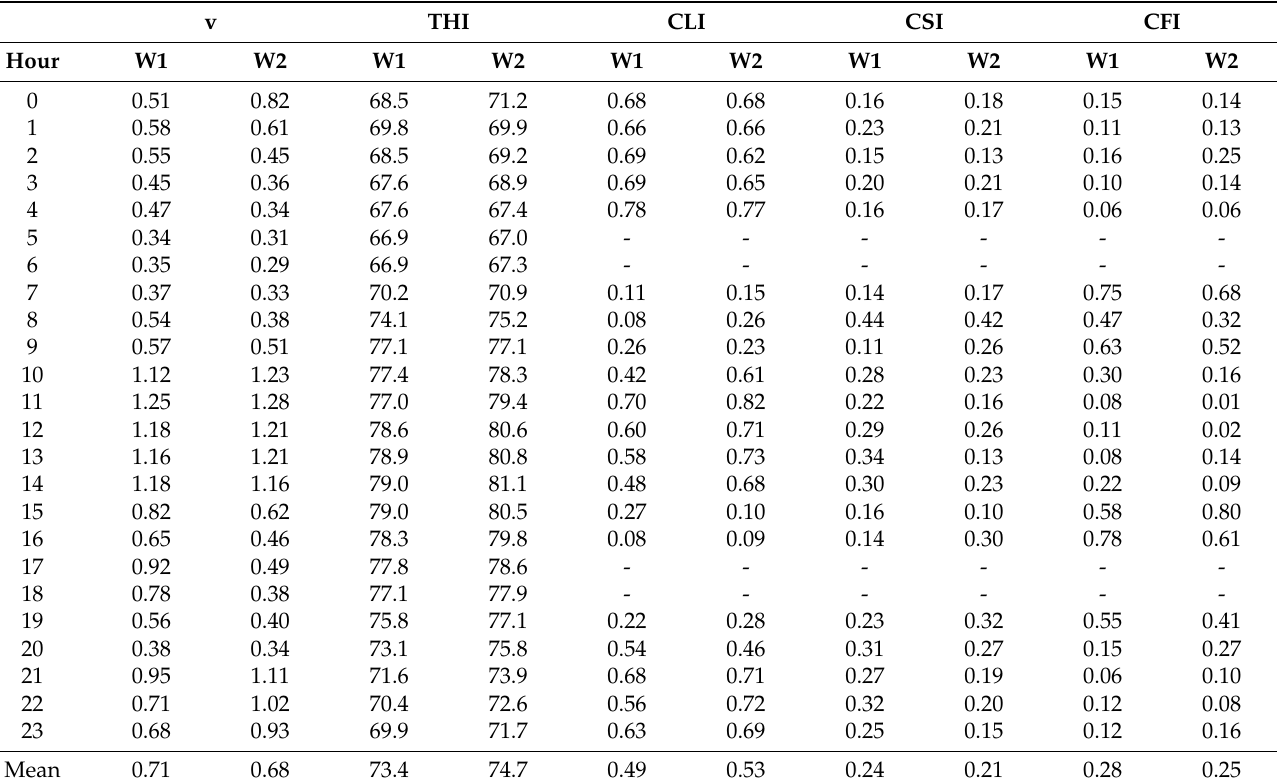
Table 2. Weekly mean values of the air velocity (v), temperature humidity index (THI) and behavioural indices (i.e., CLI, CSI and CFI) computed between 1 h intervals in both W1 and